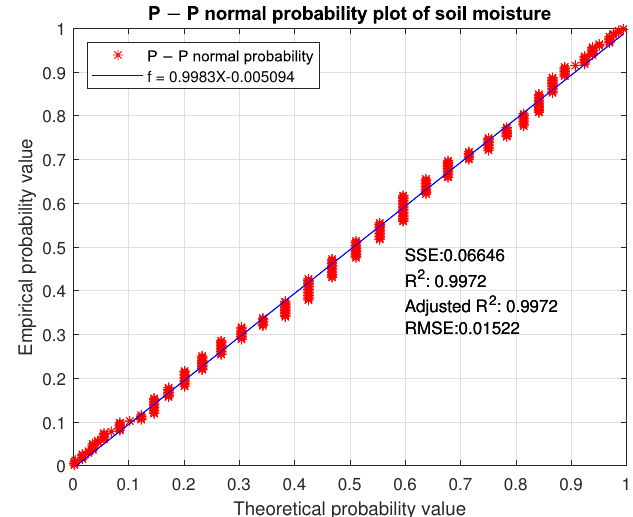
Figure 8. P-P normal probability plot of soil moisture.